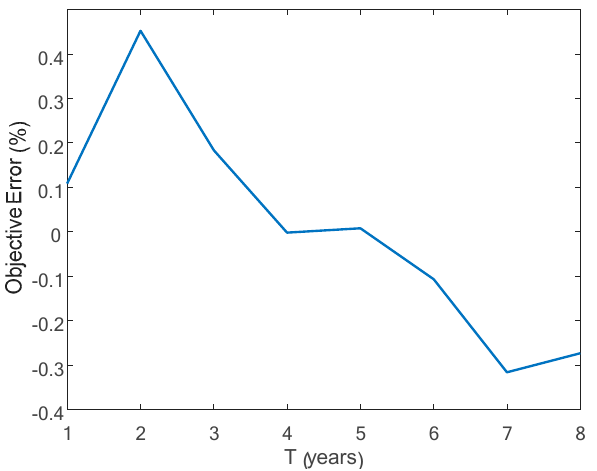
Figure 9. Objective error for the SOH compared to the best solution from IPOPT.